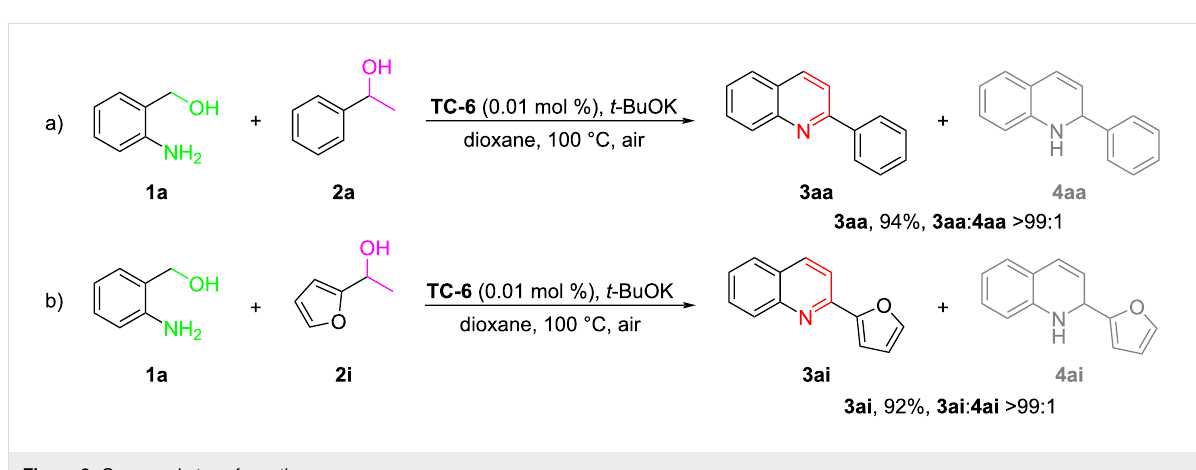
Figure 3: Gram-scale